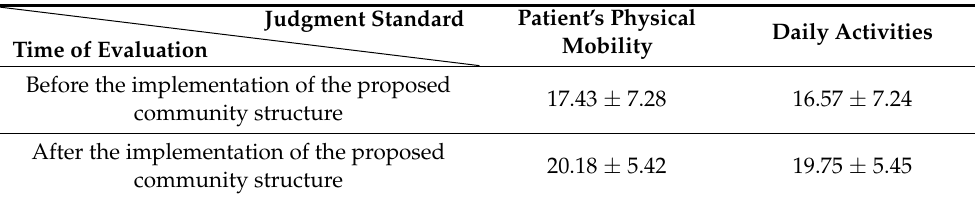
Table 4. Comparison of scores of daily activities of patients with community respiratory diseases before and after the implementation of the proposed HCC-oriented community spatial planning